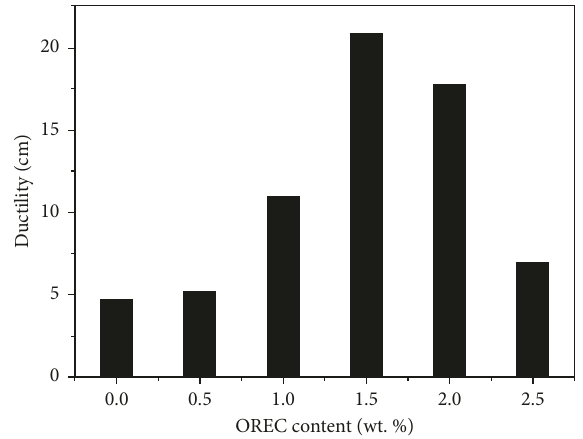
Figure 4: The ductility of WPP/OREC-modified asphalt. Table 2: The comparisons of conventional physical properties shown in previous reports.